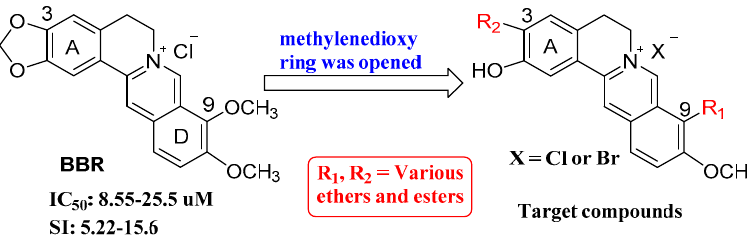
Figure 1. Chemical structure of BBR, and structure modification